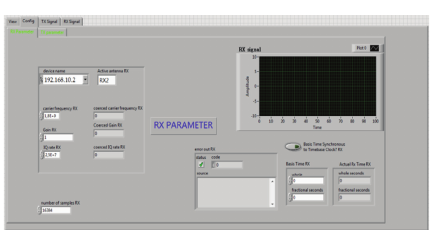
Figure 3: LabVIEW SDRadar application window.